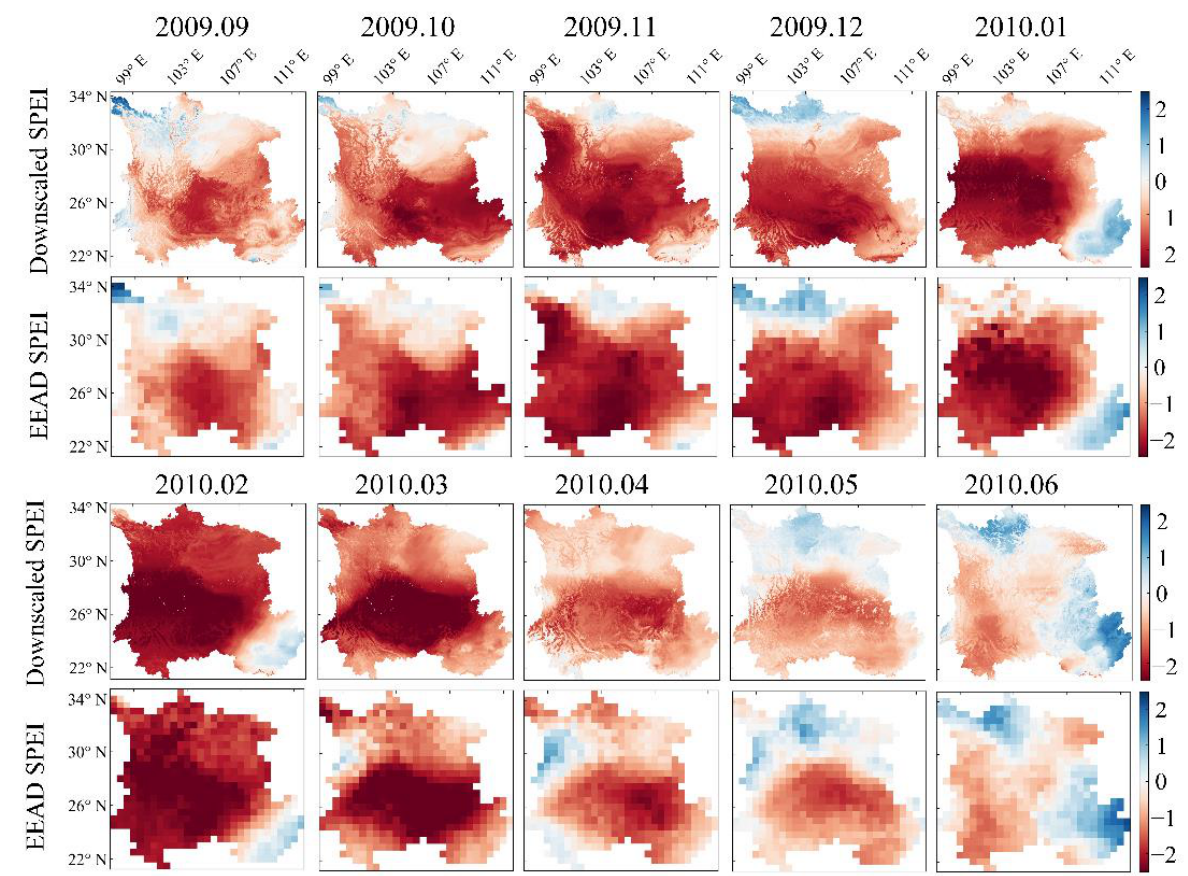
Figure 9. Drought conditions in Southwest China monitored by downscaled SPEI and EEAD SPEI from September 2009 to June 2011. The first and third rows display the downscaled SPEI, and the second and fourth rows show the EEAD SPEI.